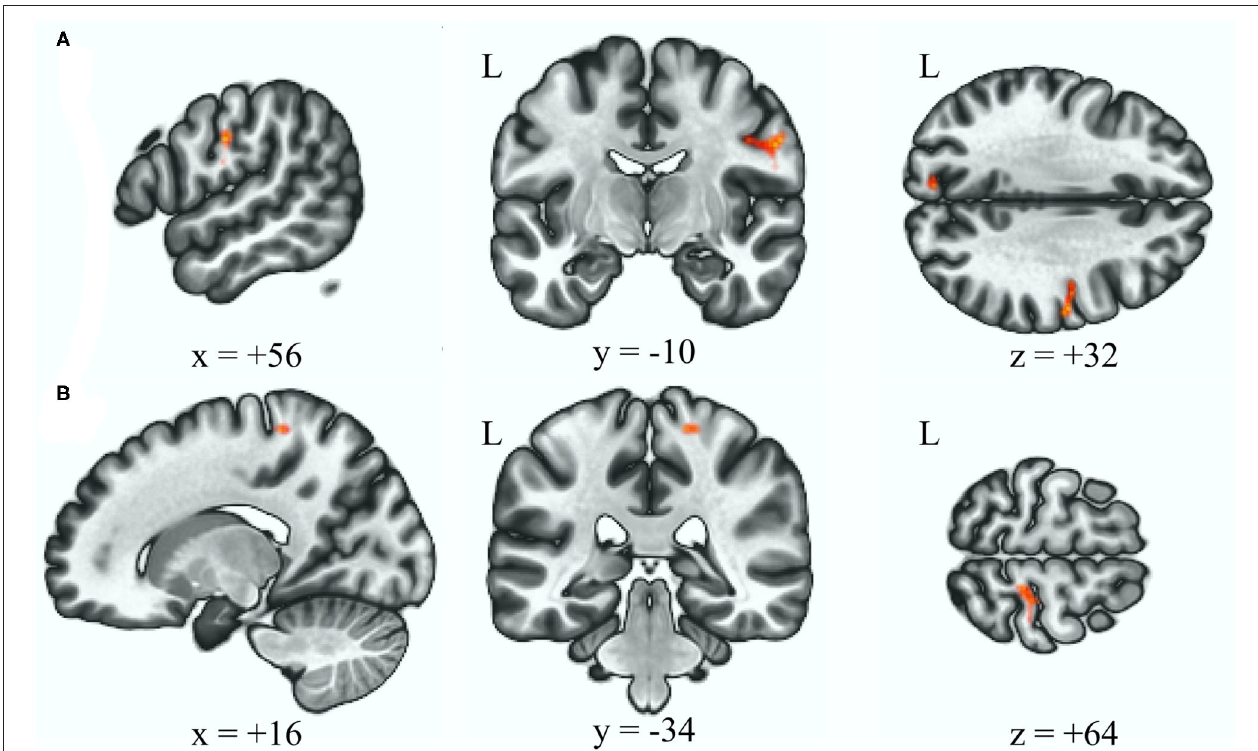
FIGURE 2 | Increased functional connectivity with the anterior cerebellum as the seed ROI ( p < 0.05, p-FDR-corrected) in the BSP group vs. HC group, over the right postcentral and precentral gyrus (A) , and over the right postcentral gyrus (B) . L, left; ROI, region of interest; BSP, blepharospasm; HC, healthy control.